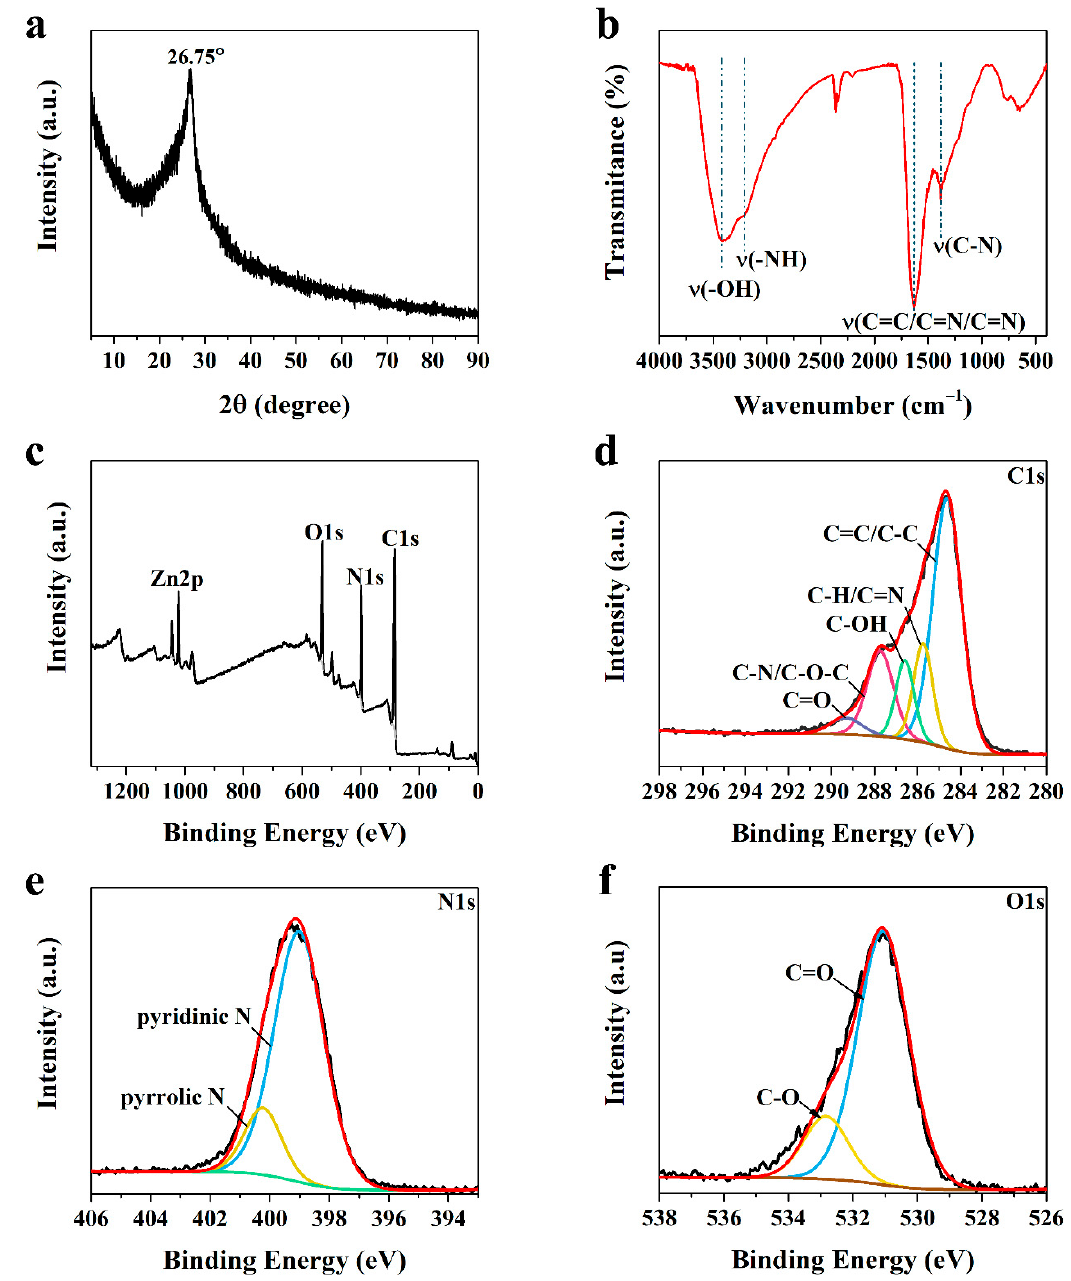
Figure 2. ( a ) XRD pattern, ( b ) FTIR spectrum, and ( c ) XPS survey spectra of N ‐ CM. ( d ) C1s, ( e ) N1s, and ( f ) O1s high ‐ resolution XPS spectra of N ‐